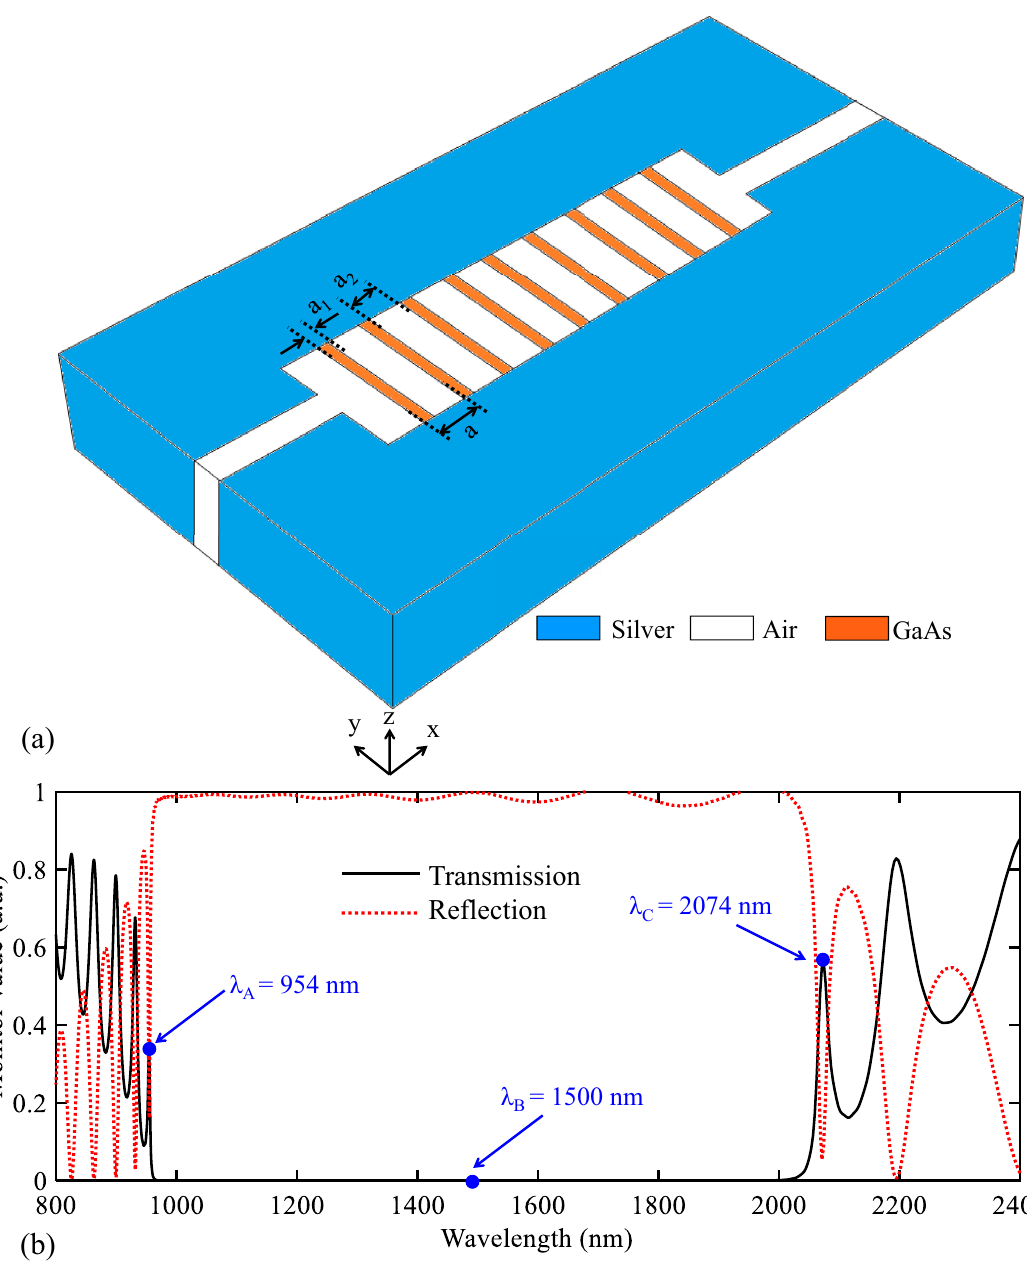
Figure 5. ( a ) 3D topology of the proposed biosensor I. ( b ) Its transmission and reflection